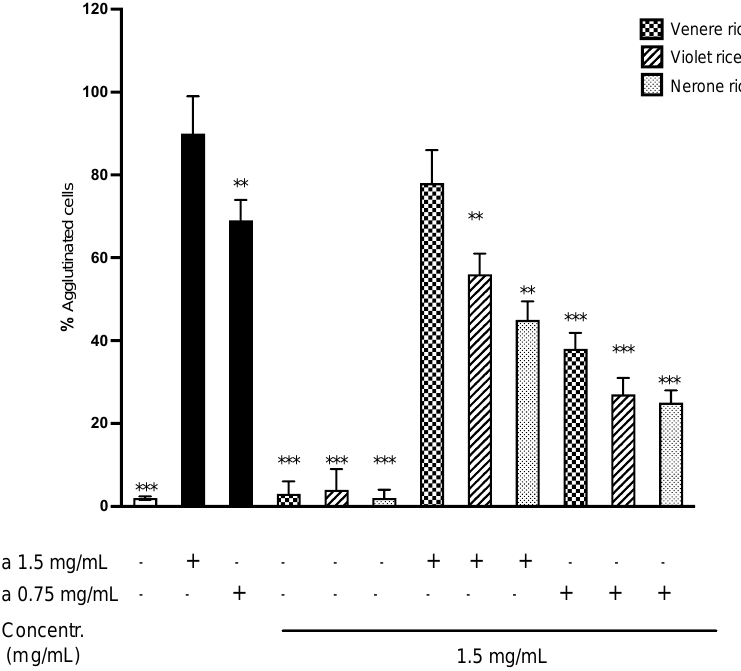
Figure 9. Agglutination test on K562(S) cells. Cells were incubated for 30 min in the presence of digested gliadin (Ga) at different concentrations (1.5 and 0.75 mg/mL) and rice extracts at 1.5 mg/mL. Unstimulated condition was also reported (white bar). A set of sample wells were incubated 30 min before with rice extracts and then incubated for another 30 min with Ga both at 1.5 mg/mL and 0.75 mg/mL. Results are expressed as % of agglutinated cells. ** p < 0.01, *** p < 0.001 vs. Ga stimulus 1.5 mg/mL.